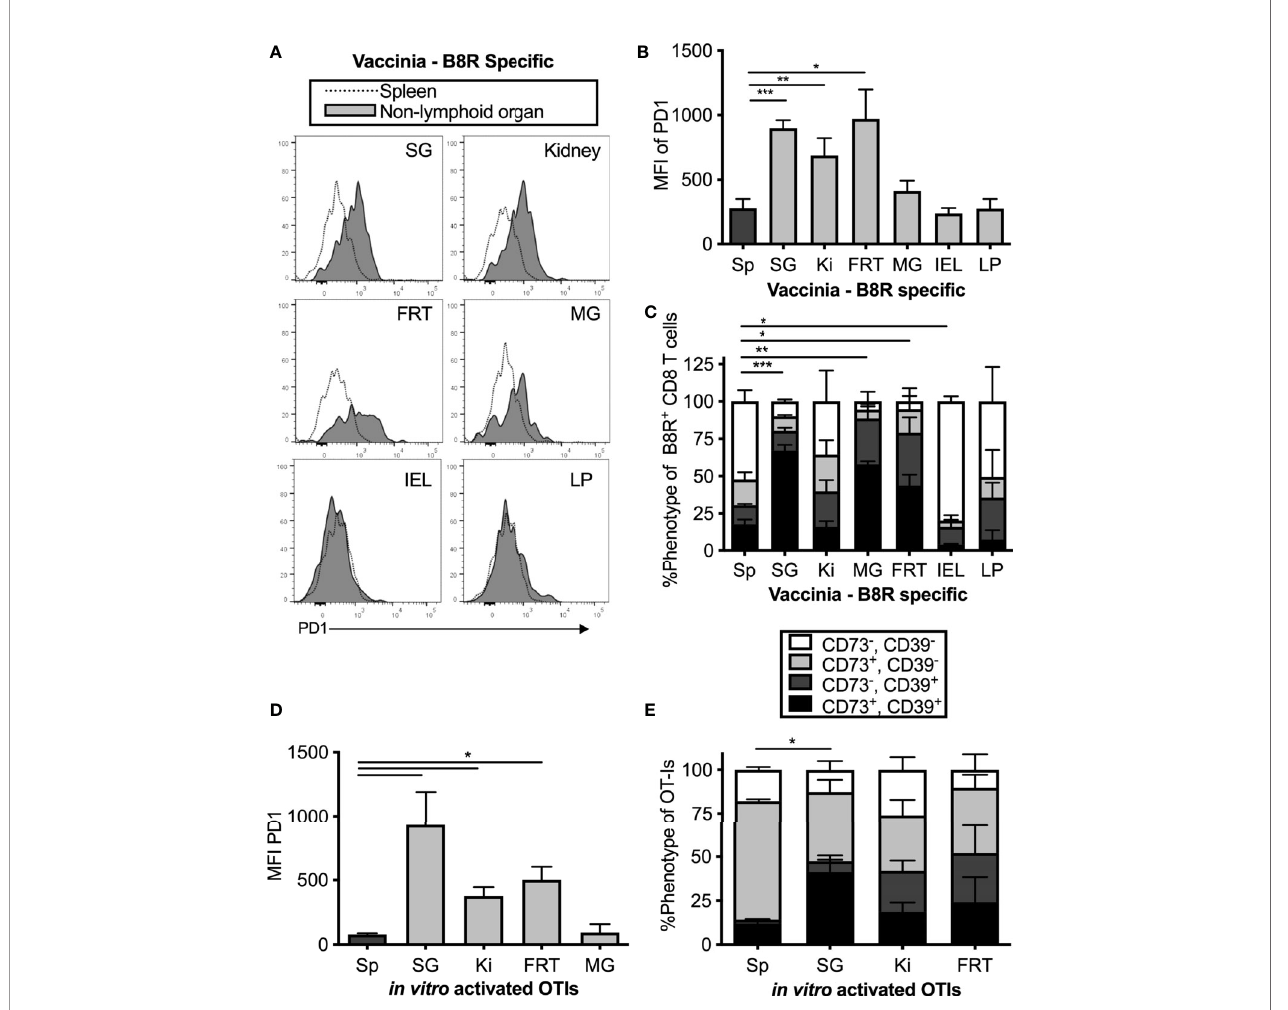
FIGURE 2 | MCMV-independent and antigen-independent expression of inhibitory molecules on tissue-localized T cells. Mice were infected with Vaccinia and virus speci fi c CD8s were identi fi ed by B8R tetramer more than 1 month post infection. (A) Representative FACS plots show PD-1 expression on i.v. antibody-negative B8R speci fi c T cells in the indicated non-lymphoid organ (grey histograms) compared to all T cells in the spleen (open histograms). (B) Mean fl uorescence intensity of PD-1 on B8R speci fi c cells from the indicated organs. Data show the mean of n=8 mice from 2 independent experiments and error bars show the standard error of the mean. (C) Frequency of CD73 and CD39 expression on B8R speci fi c T cells from the indicated organs. Data show the mean of n=3 mice from one experiment and the error bars show the standard deviation of the group. (D) OT-Is were activated with peptide in vitro for 3 days before adoptive transfer into naïve mice, which remained uninfected after transfer. OT-Is recovered from the indicated organs 2 weeks after transfer. Data show the mean fl uorescence intensity of PD-1 from recovered OT-I cells (n=3 mice per group from one experiment, representative of 3 independent experiments with 11 mice total) and the error bars show the standard deviation of the group. (E) OT-Is from the experiment in “ D ” were analyzed for expression of CD73 and CD39. Shown is the frequency of CD73 and CD39 expression on OT-Is isolated from the indicated organs from n=3 mice per group. Error bars represent the standard deviation of the group. Statistical signi fi cance in (B – E) was tested by direct comparisons between pairs of organs using paired, two-tailed student ’ s t-tests. As in Figure 1 , shown are signi fi cant differences between spleen and other organs for the MFI of PD-1 (B, D) or the frequency of cells expressing both CD73 and CD39 (C, E) . *p ≤ 0.05, **p ≤ 0.01, ***p ≤ 0.001, ****p ≤